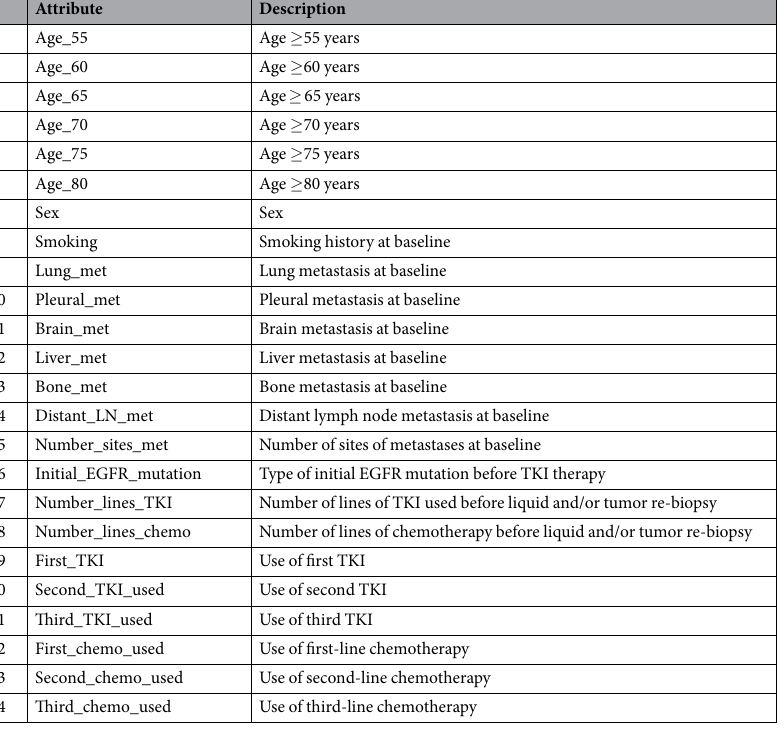
Table 5. Attributes selected for attribute ranking. EGFR: epidermal growth factor receptor, LN: lymph